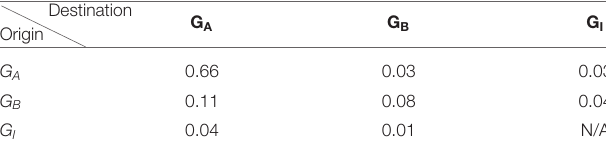
TABLE 2 | Movement probabilities between groups calculated from observed cattle movement data between 2008 and